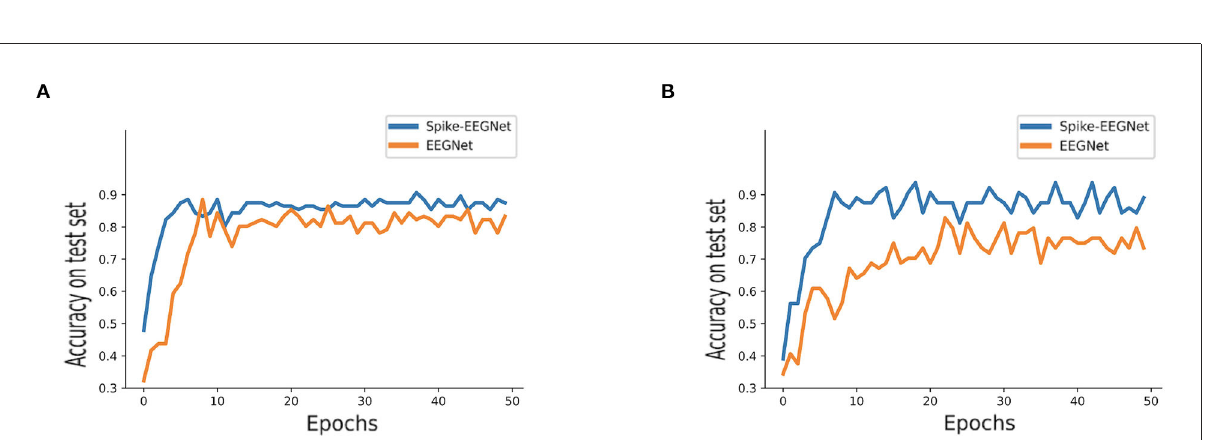
FIGURE7 The training process of Spike-EEGNet and the originial EEGNet, (A) on RAPM dataset, (B) on LSAT dataset—Spike-EEGNet and the originial EEGNet corresponding, respectively, to dark blue and orange broken